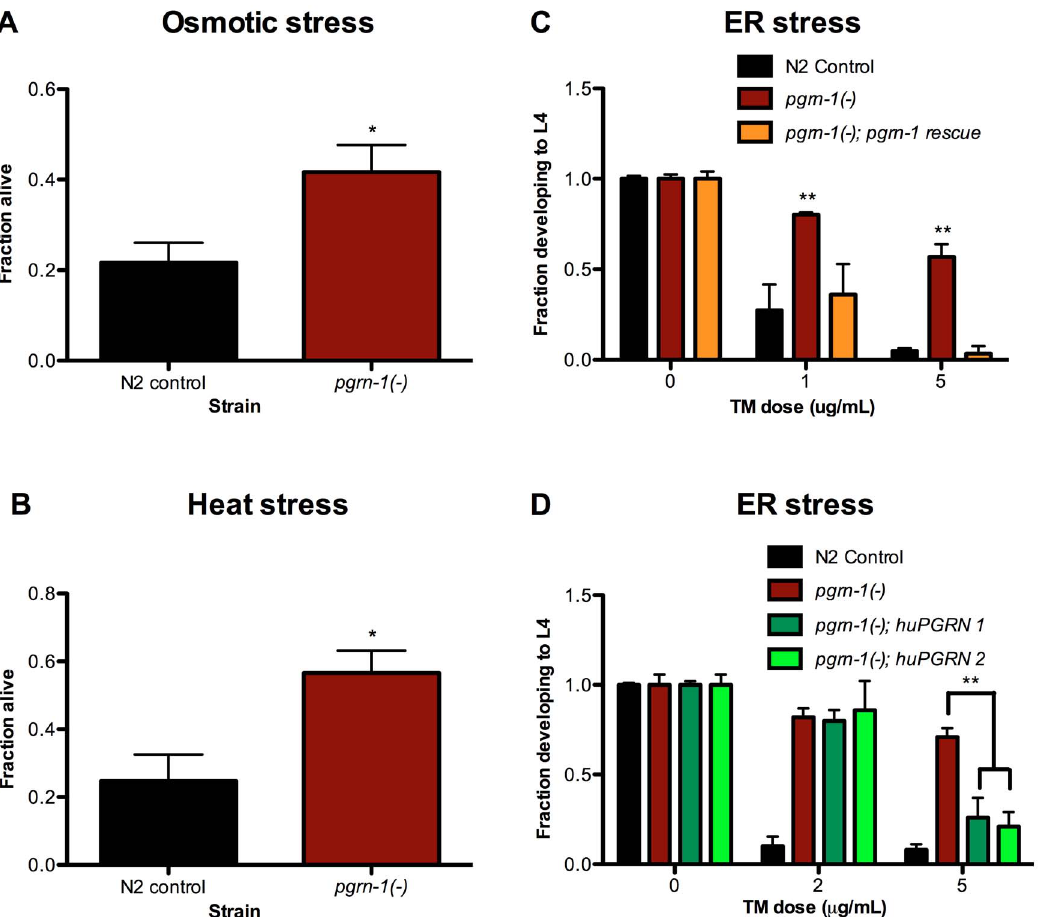
Figure 1. pgrn-1(-) mutants are resistant to osmotic, heat and ER stress. N2 control and pgrn-1(tm985) animals were subjected to various stressors and then scored for survival or ability to develop from egg to L4 stage. (A) Day 1 adult animals were treated with 600 mM NaCl for 24 hours and scored for survival (Student’s t test). (B) Day 1 adult animals were incubated at 35 u C for 8 hours and scored for survival (Student’s t test). (C) Embryos from WT, pgrn-1(-) or pgrn-1(-) expressing a C. elegans progranulin rescue construct were treated with 0, 1 or 5 m g/mL tunicamycin (TM) for 3 days to induce ER stress and scored for ability to develop to the L4 stage (Two-way ANOVA with Bonferroni post-tests). (D) Embryos from WT, pgrn-1(- ) or pgrn-1(-) expressing a human progranulin rescue construct (two independently integrated and outcrossed strains) were treated with TM as in (C) (Two-way ANOVA with Bonferroni post-tests). Results shown are representative of at least 2 experiments. Error bars represent standard deviation. Statistical comparisons here are to N2 control. n.s. not significant, *p , 0.05, **p , 0.01, ***p , 0.001. For additional statistical data, please see Table S1A–D.